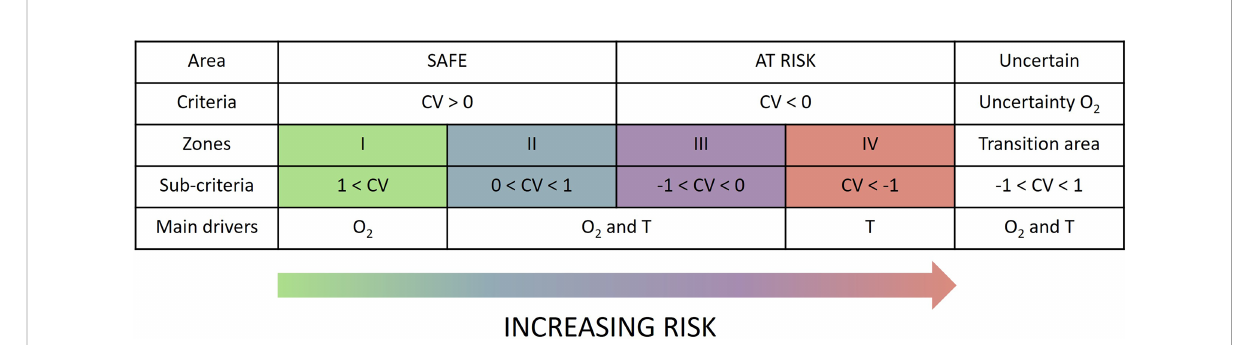
FIGURE 8 De fi nition of areas of climate change exposure. Areas with positive or negative velocities are classi fi ed as “ safe or “ at risk ” . We also distinguish area of slow velocities driven by the spatial gradient (|CV|< 1km.yr -1 , zones II and III) and areas of fast velocities driven by the temporal gradient (| CV| > 1 km.yr -1 , zones I and IV). The transition area de fi ned by a high uncertainty related to natural variability and physiological traits is classi fi ed as uncertain. To each of these areas correspond main drivers (i.e. oxygen (O 2 ) and temperature (T) as analyzed in section